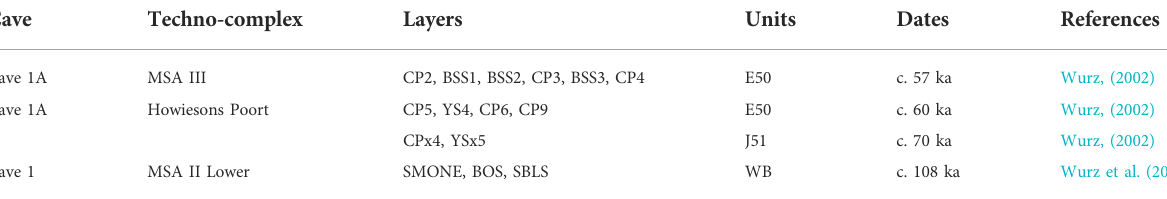
TABLE 2 Stratigraphy of the taphonomically analysed faunal sample at Klasies